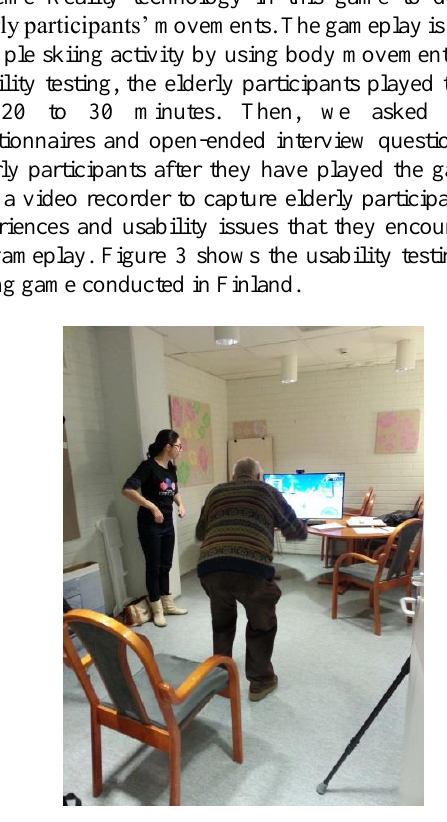
Figure 3. The usability testing of the Skiing game with a Finnish elderly